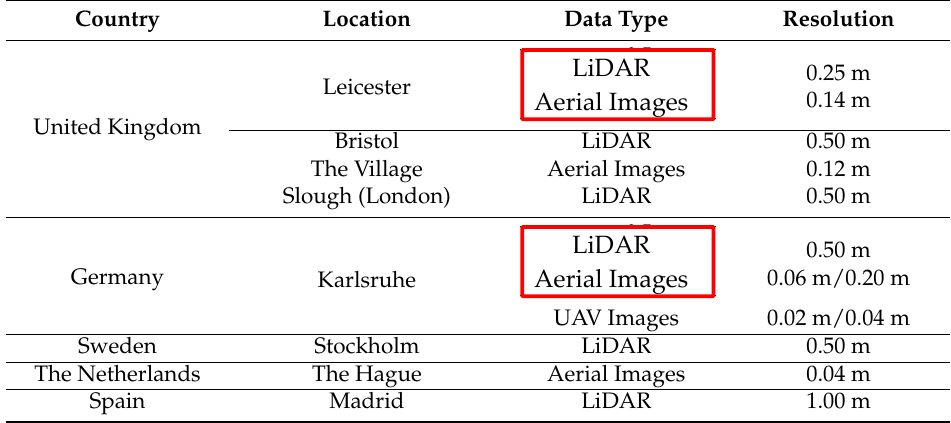
Table 1. Datasets processed by the EAGLE system. For the Karlsruhe test site, two different resolutions were available for classical aerial imagery as well as for unmanned aerial vehicles (UAV); datasets marked in red were used for quality evaluation.